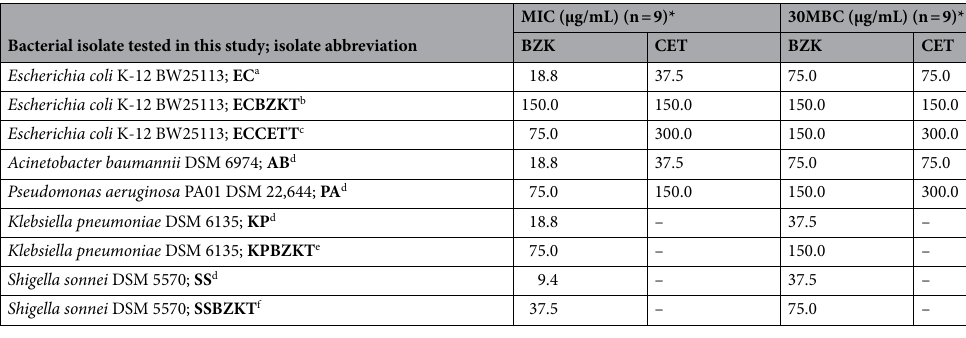
Table 1. A summary of mean BZK and CET MIC and 30MBC values of all bacterial isolates tested in this study based on a twofold (log 2 ) dilution series from three bacterial bioreplicates measured in technical triplicate. *n = 9 refers to 3 biological replicate cultures and 3 technical replicate dilutions used for AST. a Isolate sourced from the Yale Coli Genetic Stock Centre; CGSC (https ://cgsc.biolo gy.yale.edu/). b BZK-adapted BW25113 isolate, tolerant to 75 µg/mL BZK (BZKR). Refer to reference BioRXIV# 201,814. c CET-adapted BW25113 isolate, tolerant to 150 µg/mL CET (CETR). Refer to reference BioRXIV# 201,814. d Strain sourced from the Leibniz Institute DSMZ-German Collection of Microorganisms and Cell Cultures GmbH; DSMZ (https ://www.dsmz.de/). e BZK-adapted DSM 6135 isolate, tolerant to 75 µg/mL BZK. f BZK-adapted DSM 5570 isolate, tolerant to 37.5 µg/mL